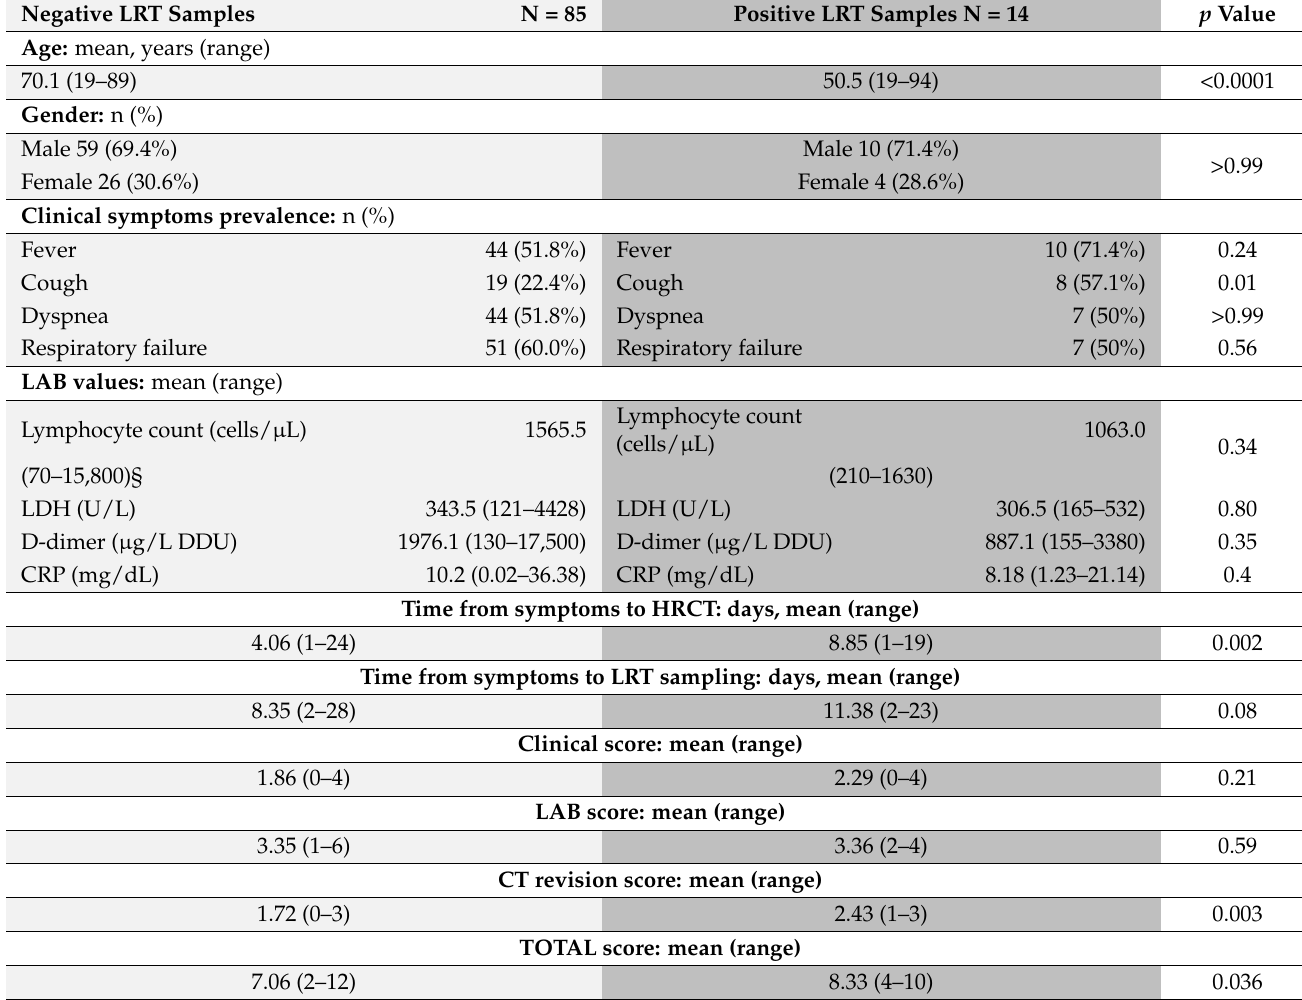
Table 4. Comparison between positive and negative samples.